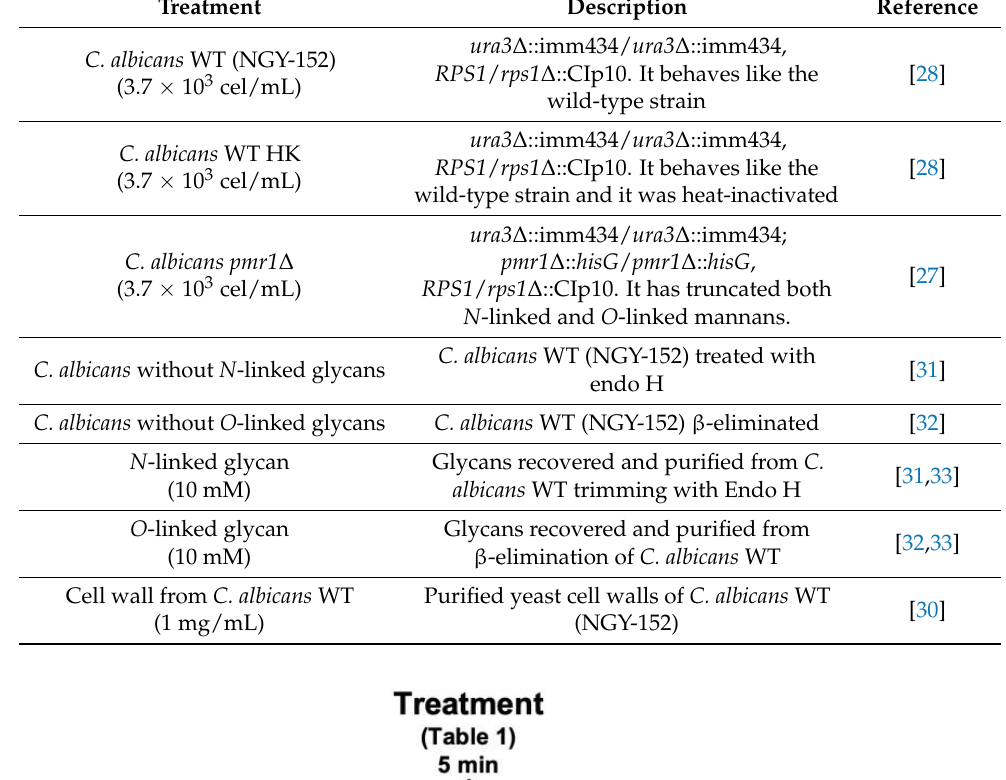
Table 1. Strains and structures of C. albicans used for interaction with the coronary endothelium. Treatment Description